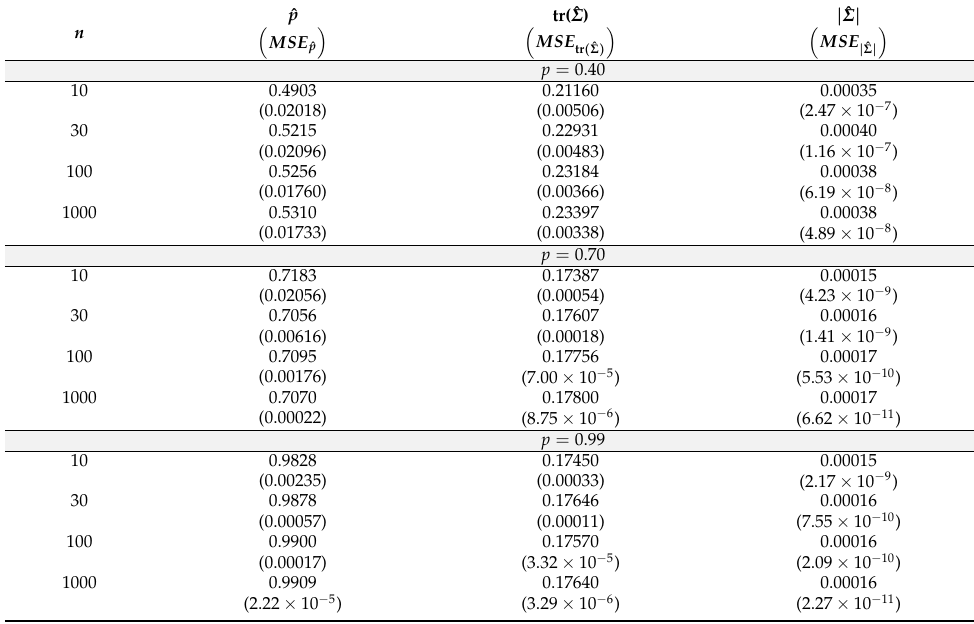
Table 3. Performance of MLEs for CG W C m